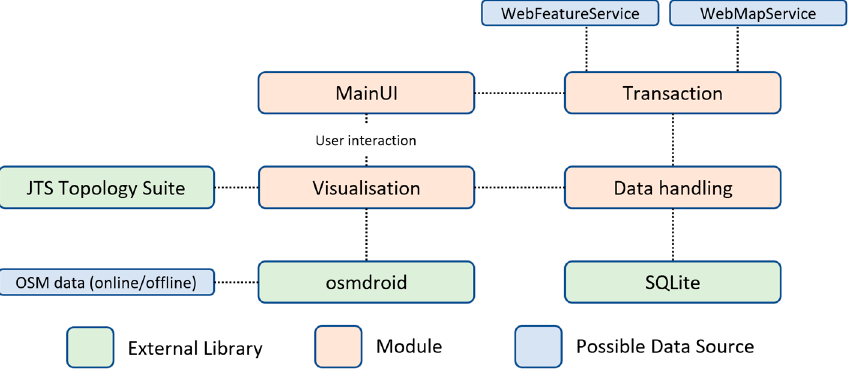
Figure 5. System design of GeoTechMobile.